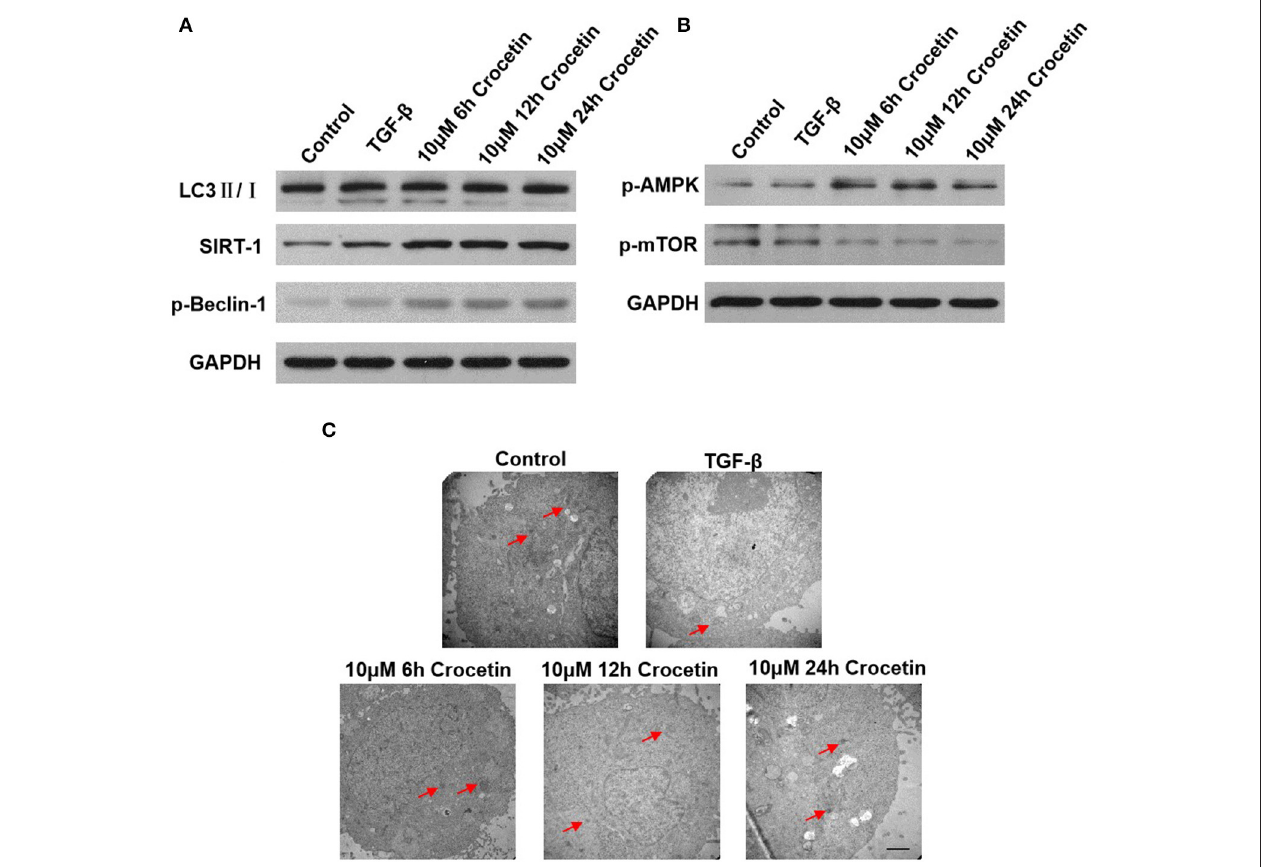
FIGURE 3 | Crocetin pre-treatment promoted LO2 cell autophagy via regulating the AMPK/m-TOR signaling pathway. (A) The level of SIRT-1, LC3II/I, and Beclin-1 were examined by western blot. (B) AMPK/m-TOR signaling pathway-related protein was assessed by Western Blot. (C) The autophagy process was observed using TEM